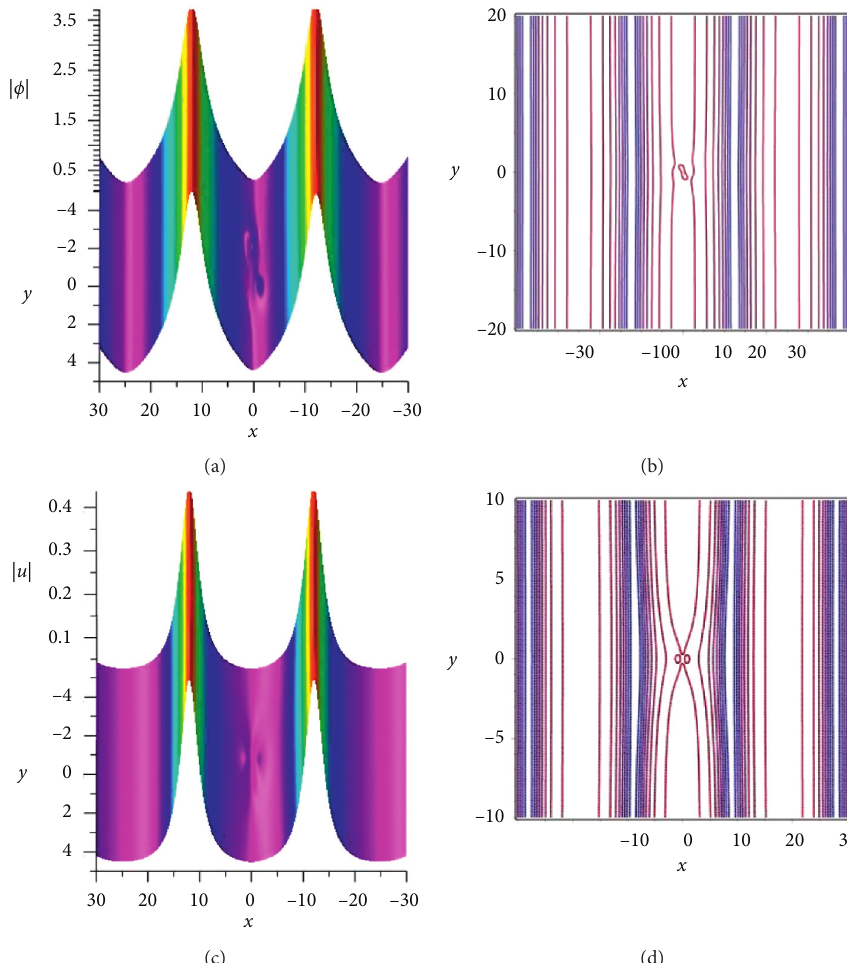
Figure 8: Semirational solutions constituting of a lump and periodic line waves for the nonlocal Mel ′ nikov equation with parameters � 1 ,P � 1/3 , and η 0 � − ( π /6 ) . The panels (b) and (d) are the contour plots of the panels (a) and (c), λ 0 3 3